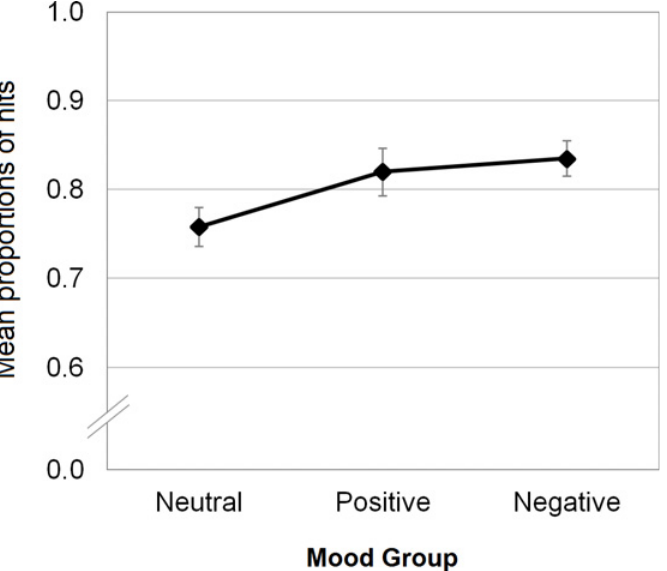
Fig 2. Mean proportions of hits as a function of mood group; error bars represent standard errors.